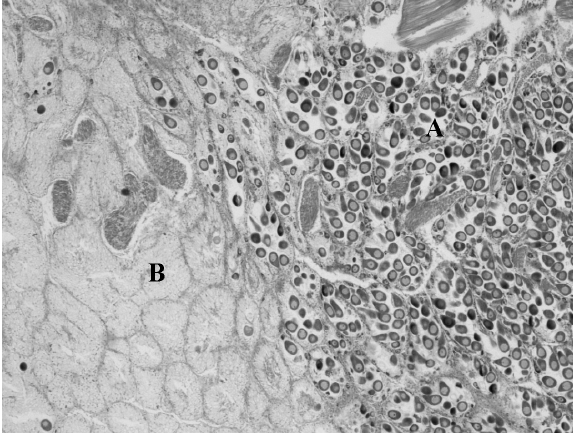
Fig . 5. – Detail of different stages of gonadal development coexist-Detail of different stages of gonadal development coexist- ing in the same V. senegalensis individual. A, early/late active; B, spent.